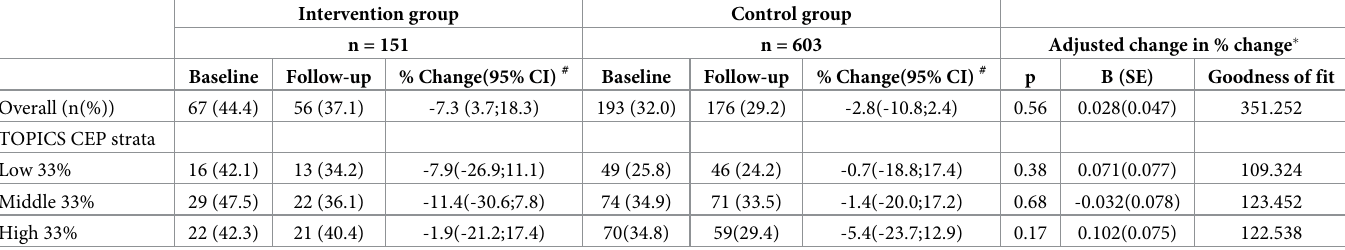
intervention and control groups calculated using the ‘Generalized estimation equation’ (GEE) method is 0.56. Within the strata of low, middle and high of TOPICS-CEP, these values are respectively -7.9 and -0.7 (p = 0.38), -11.4 and -1.4 (p = 0.68) and -1.9 and– 5.4 (p = 0.17). Table 2. Changes in percentage of respondents that are very satisfied about GP care over 1-year follow-up during implementation of integrated care in the interven- tion group compared to control group, depending on perceived health state. Intervention group Control group Baseline